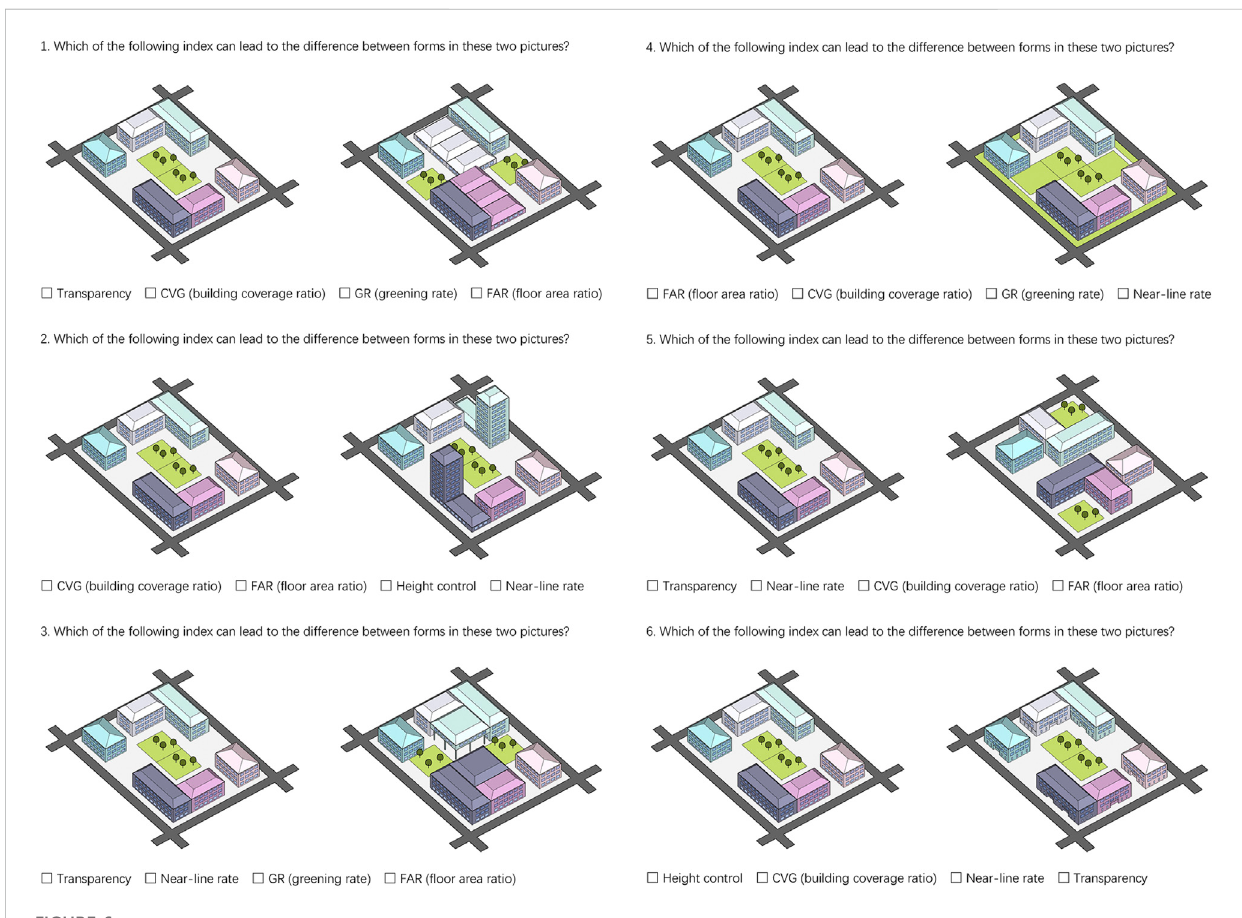
FIGURE 6 Items on the